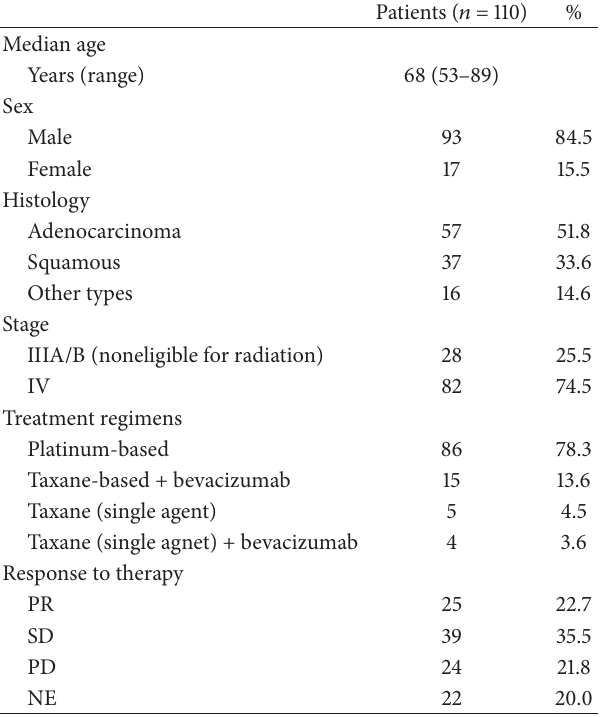
Table 1: Patients’